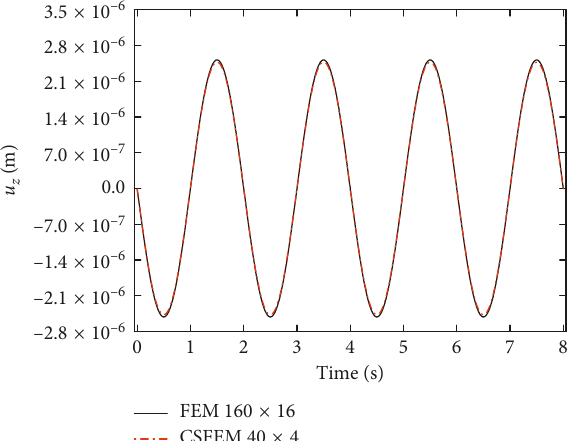
Figure 20: The variation of the displacement u